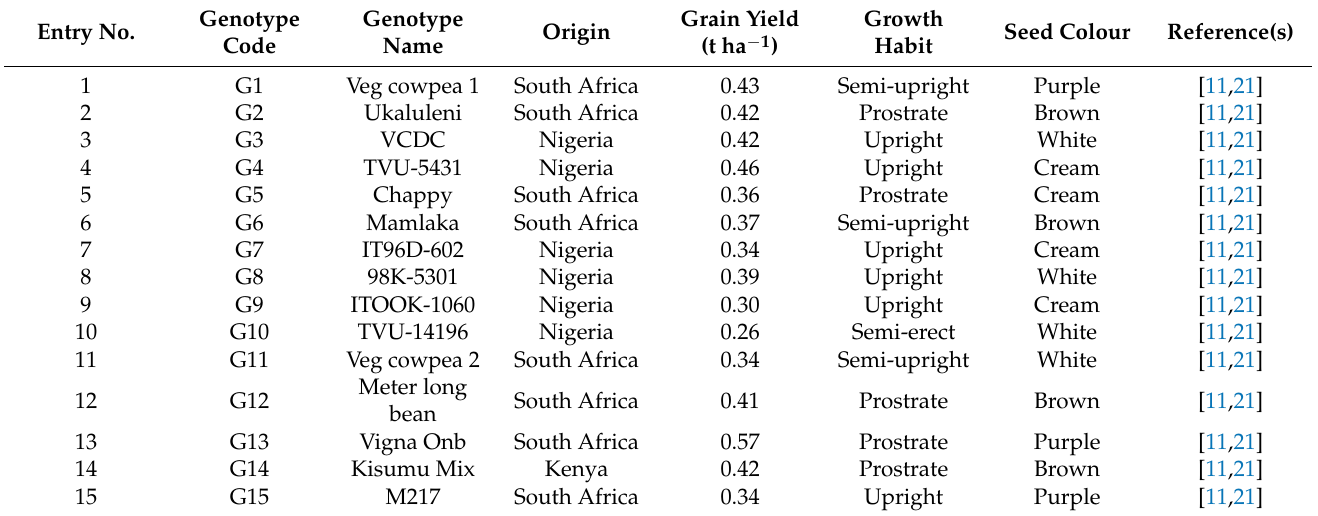
Table 1. List of cowpea genotypes used in the study (Source: [11,21]).